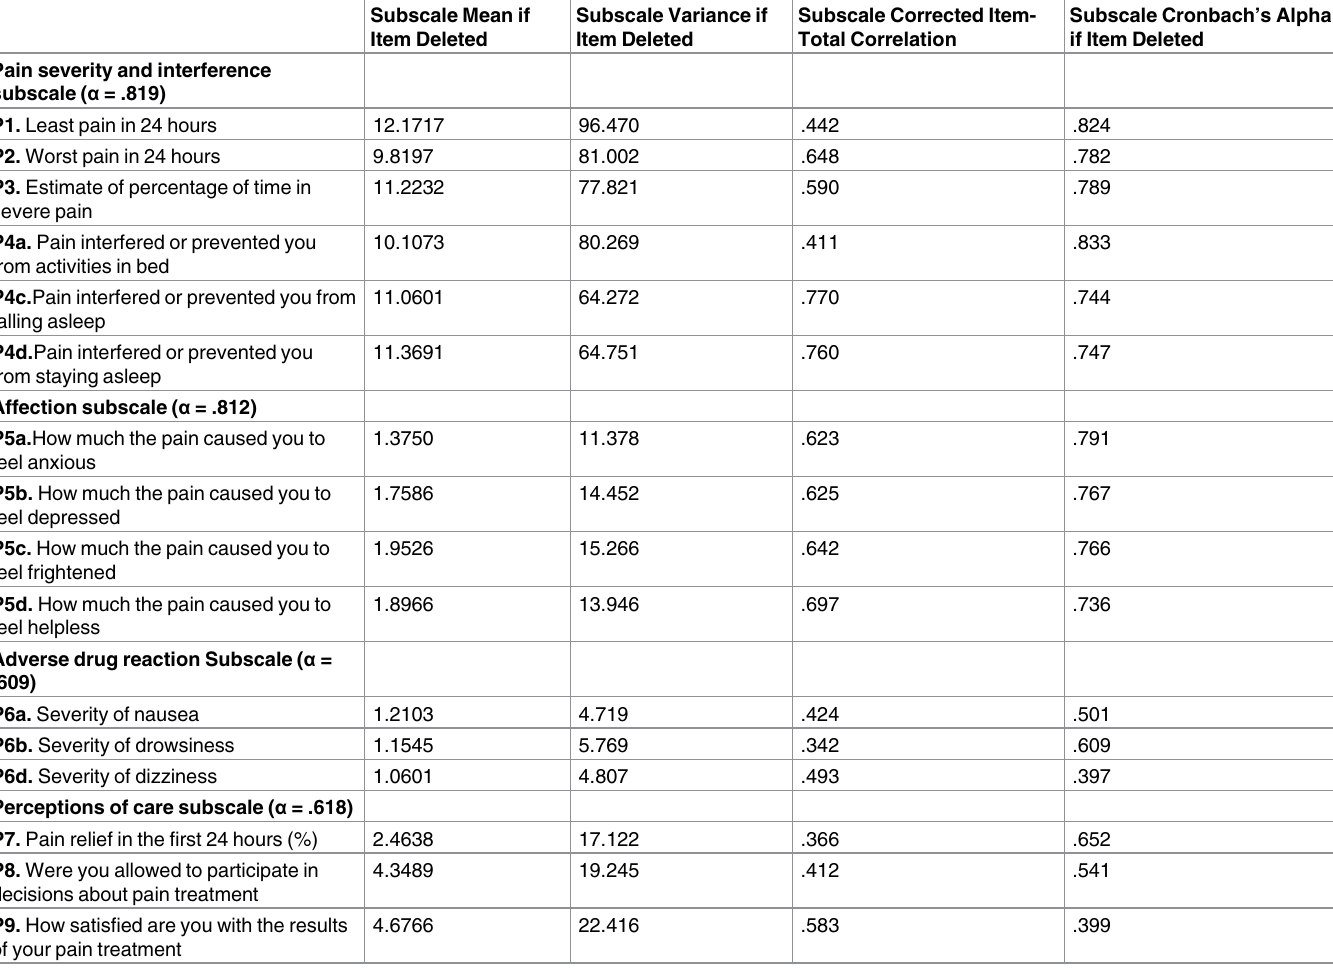
Table 3. Final subscale item-total statistics.